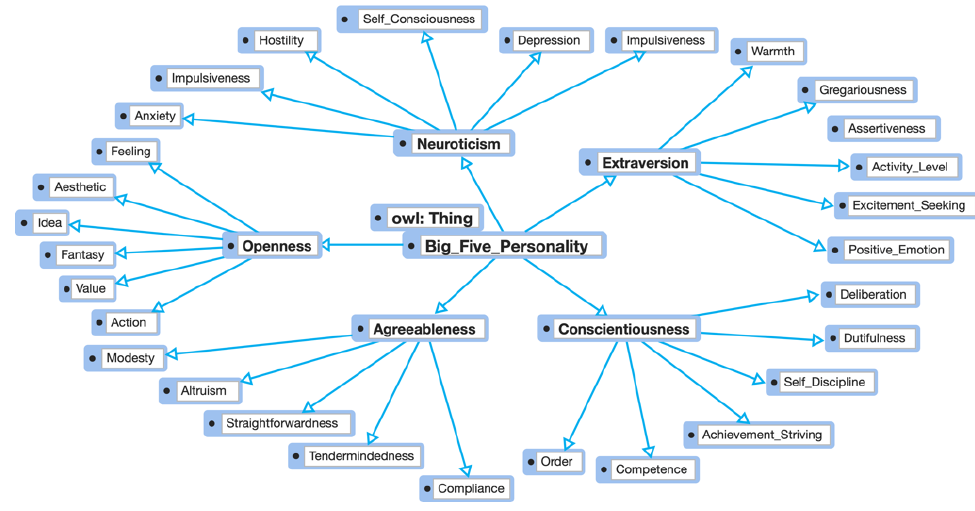
Figure 2. OWL Protégé Visualization. Figure 2. OWL Prot é g é Visualization. Table 1. Big Five Personality Traits.